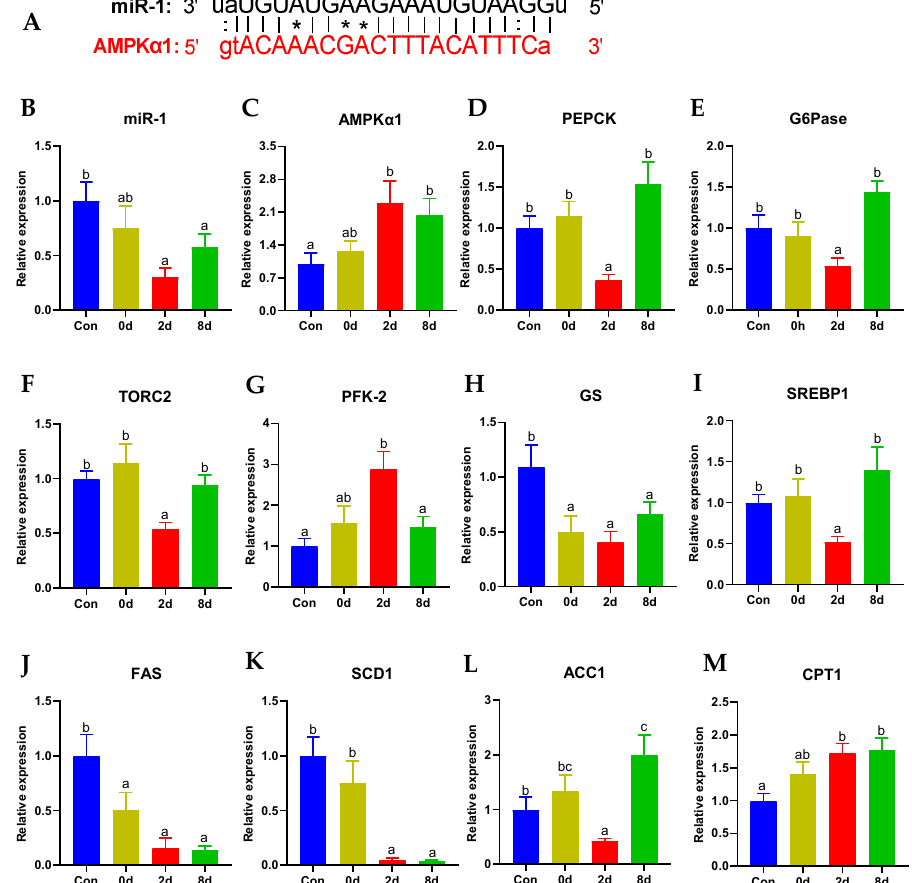
Figure 8. miR-1/AMPK signaling was involved in glucose and fatty acid metabolism under chronic hypothermia. ( A ) target prediction between miR-1 and AMPKα1; ( B ) miR-1; ( C ) AMP-activated protein kinase, AMPK; ( D ) Phosphoenolpyruvate carboxykinase, PEPCK; ( E ) Glucose-6-phosphatase, G6Pase; ( F ) CREB-regulated transcription coactivator 2, TORC2; ( G ) 6-phosphofructo-2-kinase-2, PFK-2; ( H ) Glycogen synthase, GS; ( I ) Sterol regulatory element-binding transcription factor 1, SREBP1; ( J ) Fatty acid synthase, FAS; ( K ) Stearoyl-CoA desaturase 1, SCD1; ( L ) Acetyl-CoA carboxylase 1, ACC1; ( M ) Carnitine O-palmitoyltransferase 1, CPT1. Data were calculated by one-way ANOVA analysis with SPSS 23.0. The significant differences are considered to exist when p < 0.05, and marked with different letters. Results were expressed as mean ± SEM, n = 9.